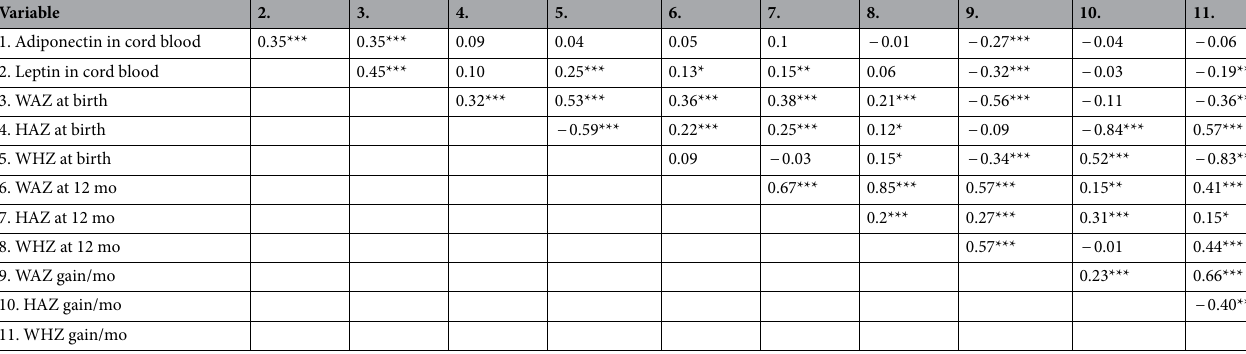
Table 2. Pearson correlation coefficients between cord blood adipokines and infant growth. Adiponectin (μg/ mL) and leptin (ng/mL) were ln-transformed. WAZ weight-for-age z-score, HAZ height-for-age z-score,